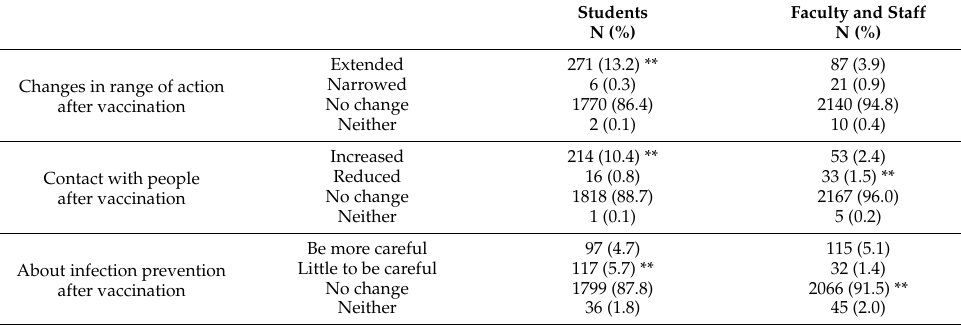
Table 4. Comparison of students and faculty and